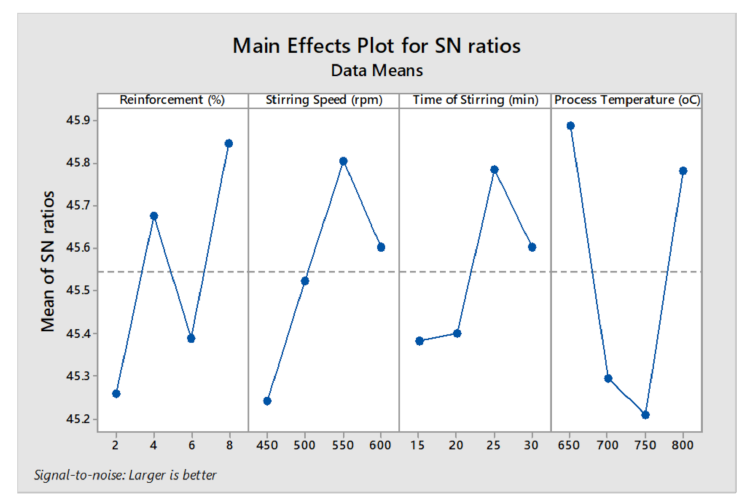
Figure 16. Main effect plot for SN ratios (micro hardness).